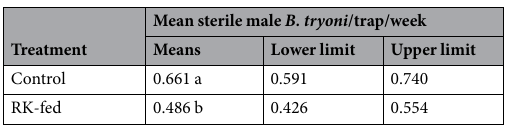
Table 2. Mean number of sterile male B. tryoni trapped per week, when supplemented pre-release as immatures (2-3 days) with raspberry ketone (RK), or denied RK (i.e. control) across a commercial orchard. Mean value followed by the differing letters are significantly different from one another (p >